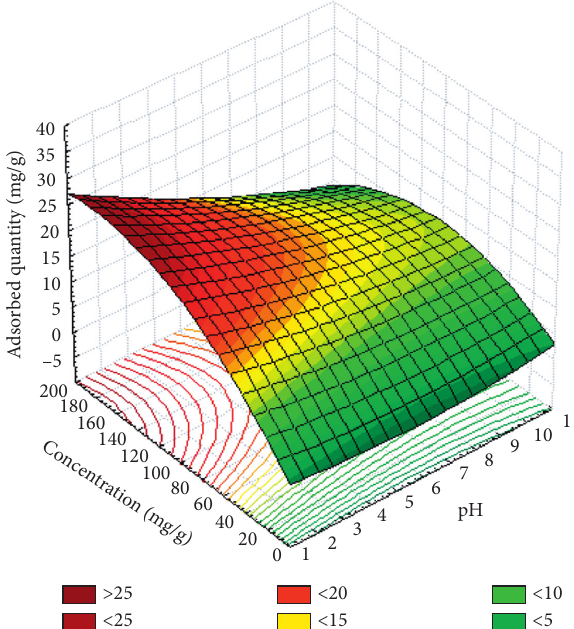
Figure 4: 3D surface graph of the adsorbed quantities of R by CAK- S as a function of concentration and